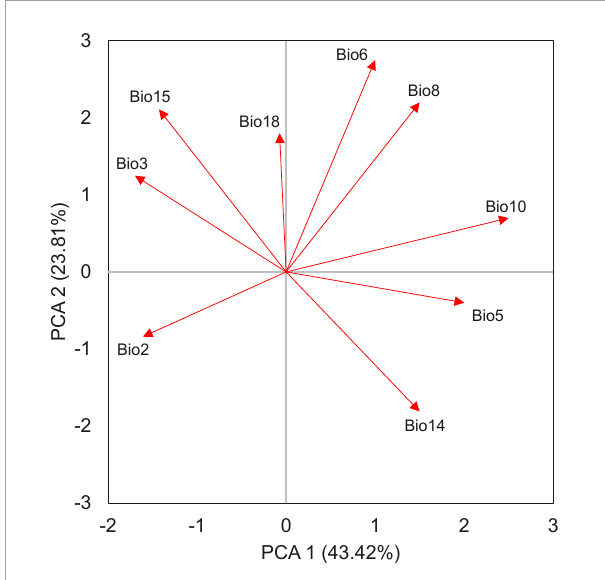
FIGURE2 Principal component analysis (PCA) of nine bioclimatic variables for the 125 occurrence records of Mimosa bimucronata . The first PCA axis accounts for 43.42% of the total variance, mainly representing the mean temperature of the warmest quarter (Bio10), the maximum temperature of the warmest month (Bio5), and isothermality (Bio3). The second PCA axis accounts for 23.81% of the total variance, mainly representing the minimum temperature of the coldest month (Bio6), the mean temperature of the wettest quarter (Bio8), and the precipitation of the driest month